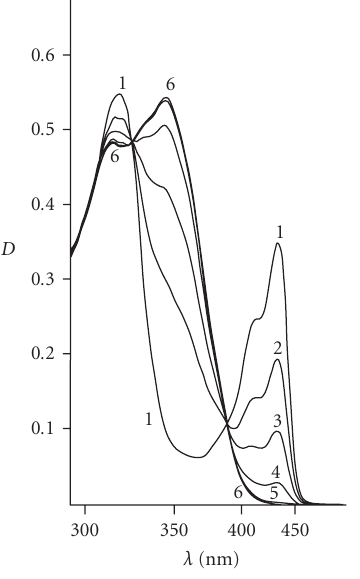
Figure 1: Absorption spectra of (8b) in toluene solution before irradiation ( 1 ); after 5 seconds ( 2 ); 10 seconds ( 3 ); 20 seconds ( 4 ); 40 seconds ( 5 ); 120 seconds ( 6 ) of irradiation ( λ irr = 436 nm, C = 2 . 5 · 10 − 5 M).